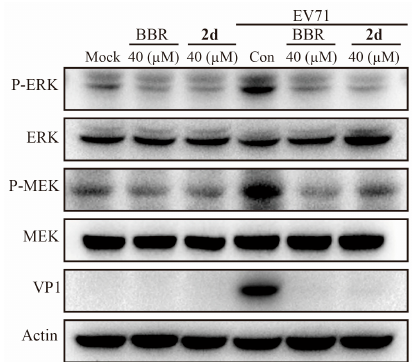
Figure 3. Compound 2d inhibits the phosphorylation of MEK/ERK with BBR as a control. Vero cells (9 × 10 5 cells/well) were plated into 6-well culture plates and were mock-infected or infected with EV71 (H, MOI = 0.1) for 1 h. The cells were then treated with compound 2d for 24 h and were harvested for western blot assay.